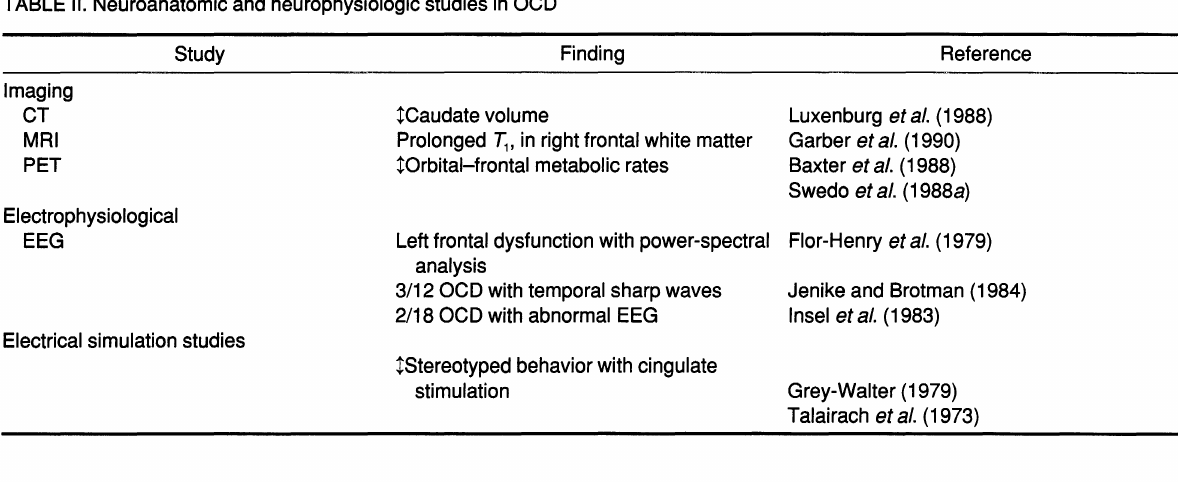
TABLE II. Neuroanatomic and neurophysiologic studies in